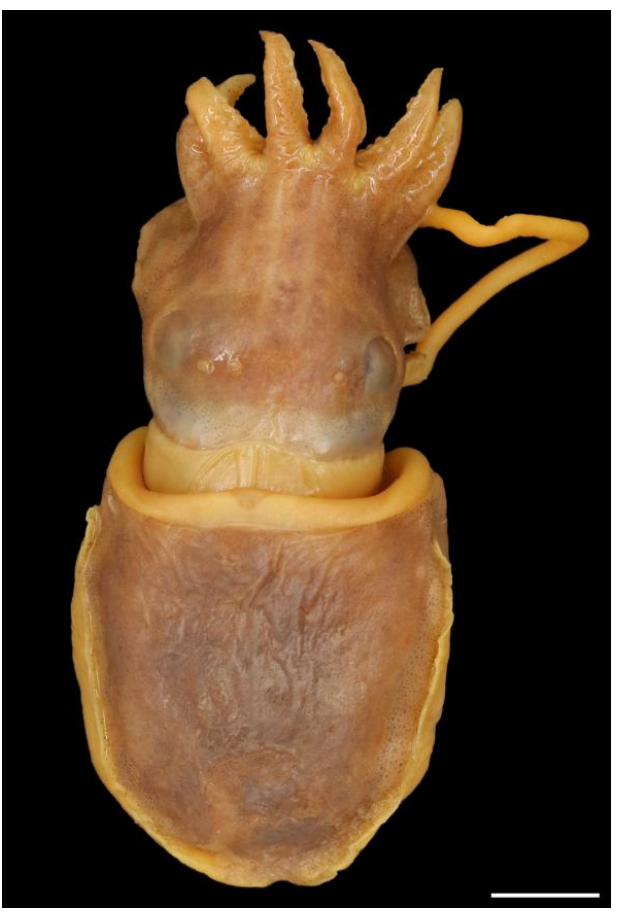
Figure 9. Sepia typica (SAIAB 211590, female ML 20 mm) showing the nuchal cartilage and the width of the neck relative to the mantle opening. Scale bar 5 mm.